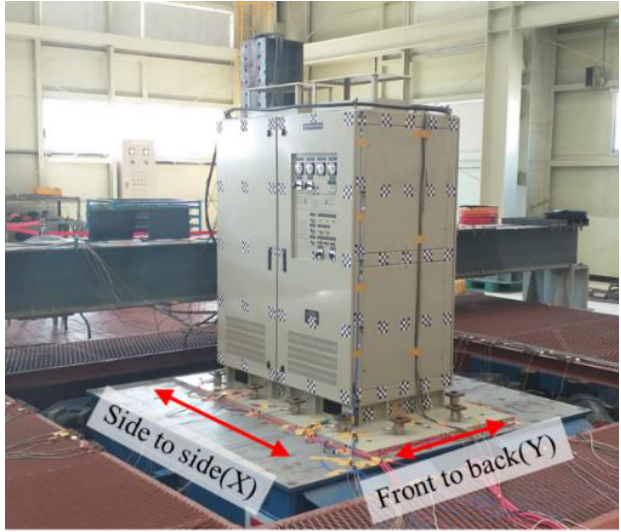
Figure 3. Test setup.